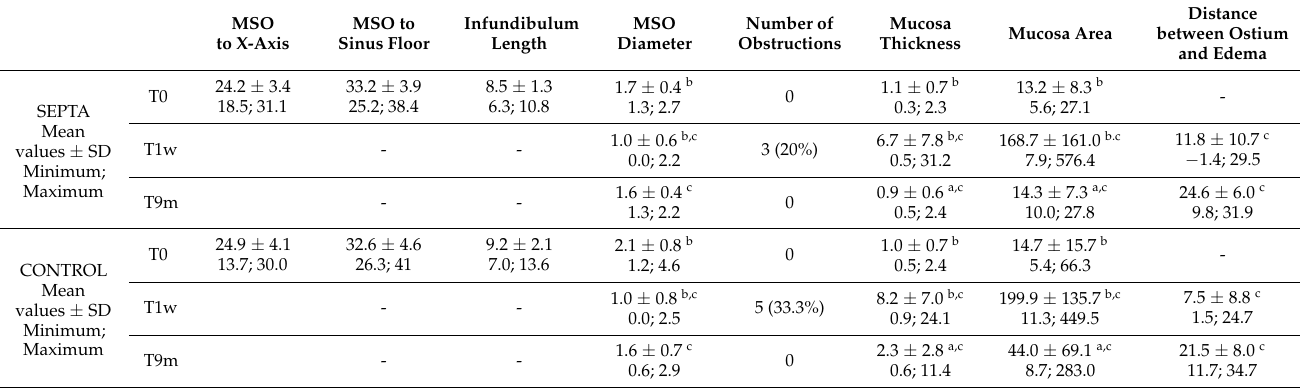
Table 2. Radiographic anatomical measures in the coronal view of CBCTs taken at T0 (before surgery), at T1w (1 week after surgery), and at T9m (9 months after surgery). Data in millimeters or square millimeters only for the mucosa area. MSO MSO to Infundibulum MSO Number of Mucosa to X-Axis Sinus Floor Length Diameter Obstructions Thickness Mucosa Area